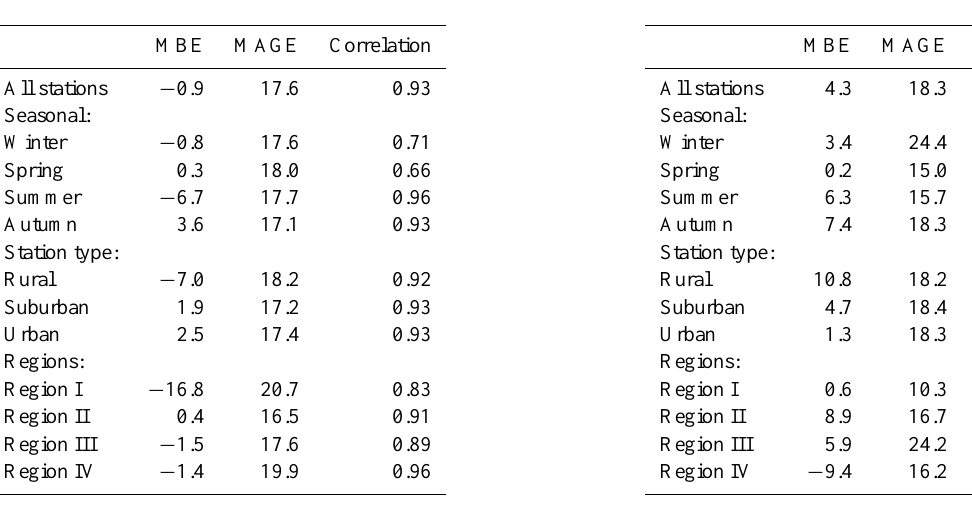
Table 1. Error statistics for GEM-AQ model performance – maxi- mum 8h running average of ozone concentrations in µgm − 3 .